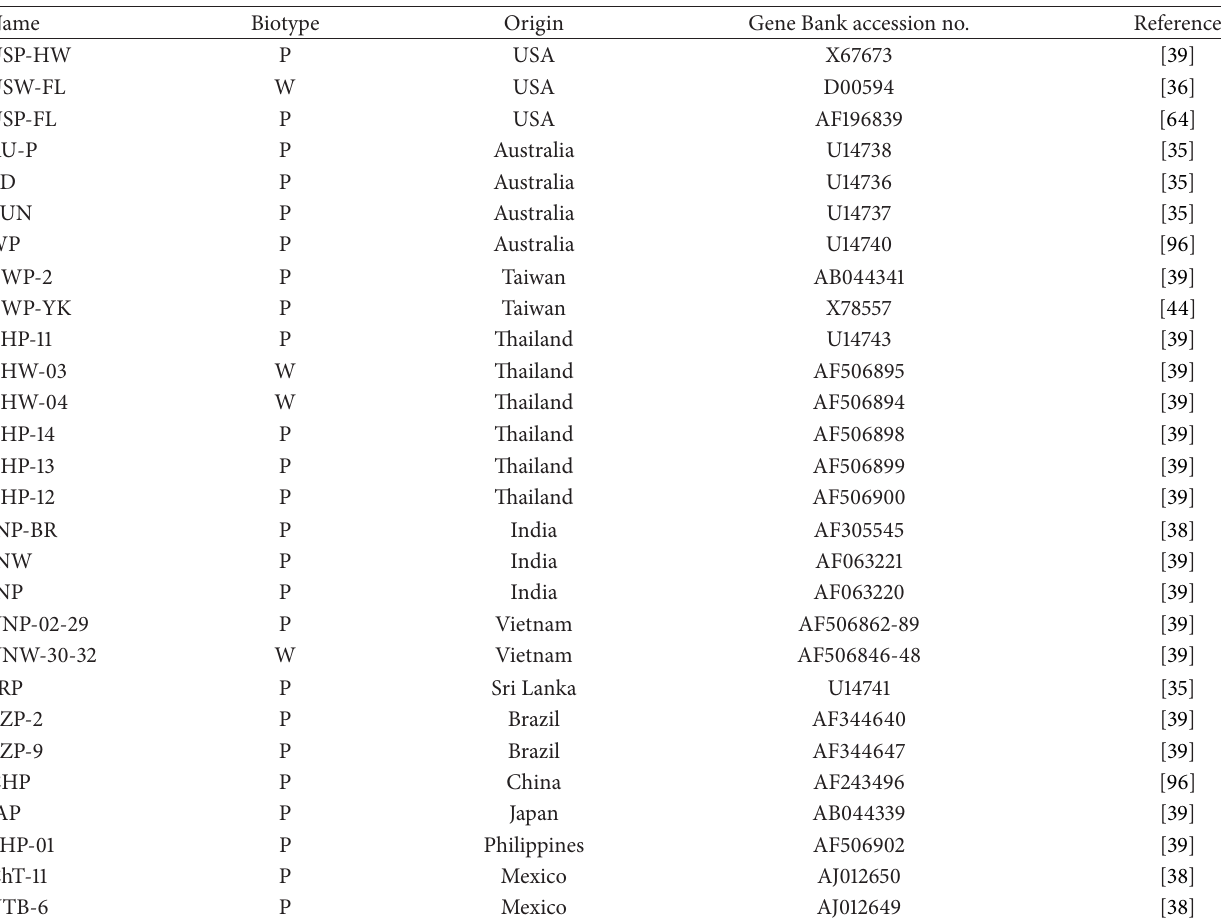
Table 1: PRSV isolates and sequence for PRSV CP